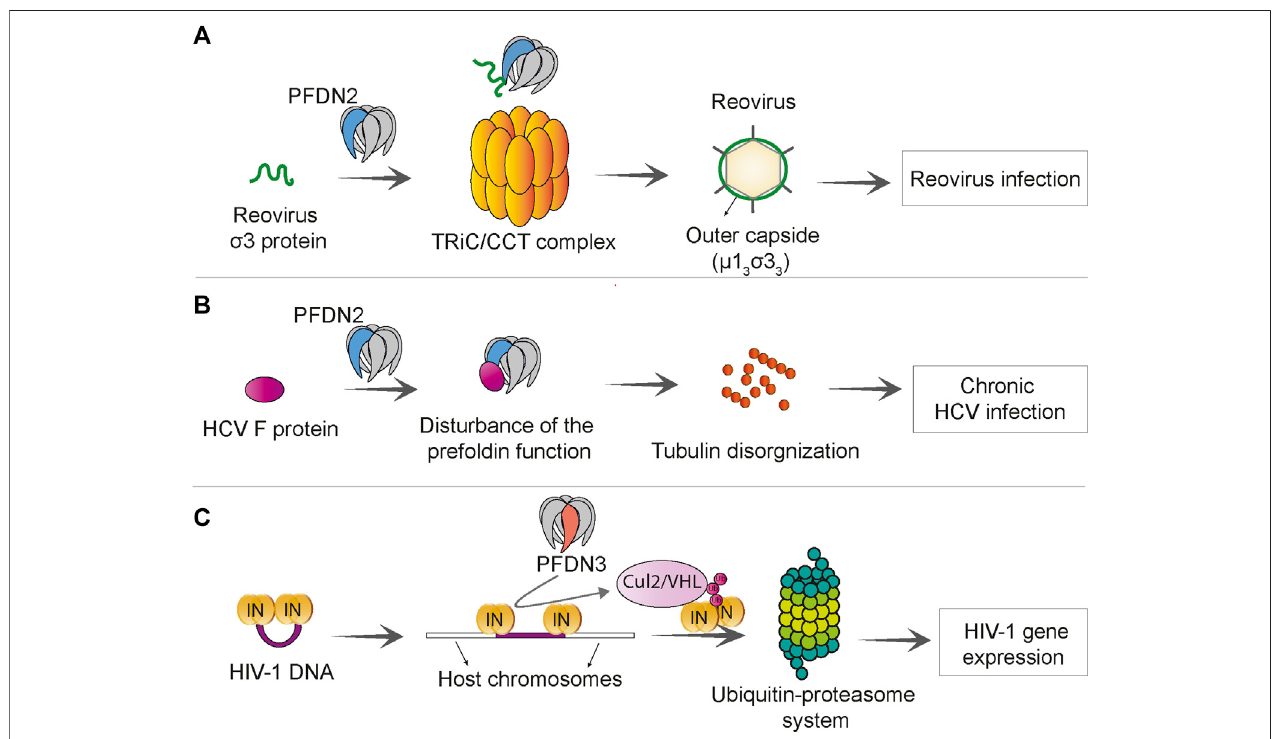
FIGURE 6| Prefoldin islinked to viral infections. (A) PFDN2 subunit of the prefoldin complexinteractswith reovirus σ 3protein and increases the ef fi ciency ofTRiC/ CCT -mediated μ 1 3 σ 3 3 assembly, which promotes reovirus infection. (B) The Hepatitis C virus (HCV) F protein interacts with PFDN2 and disturbs the normal function of prefoldin complex in microtubule organization. This leads to persistence of virus in chronic HCV infection. (C) PFDN3 speci fi cally interacts with HIV-1 integrase (IN) and mediates its interaction with cullin 2/VHL (Cul2/VHL) ubiquitin ligase, which subsequently leads to integrase “ polyubiquitination ” and proteasome-dependent degradation. This process promotes HIV-1 gene expression at a post-integration step.